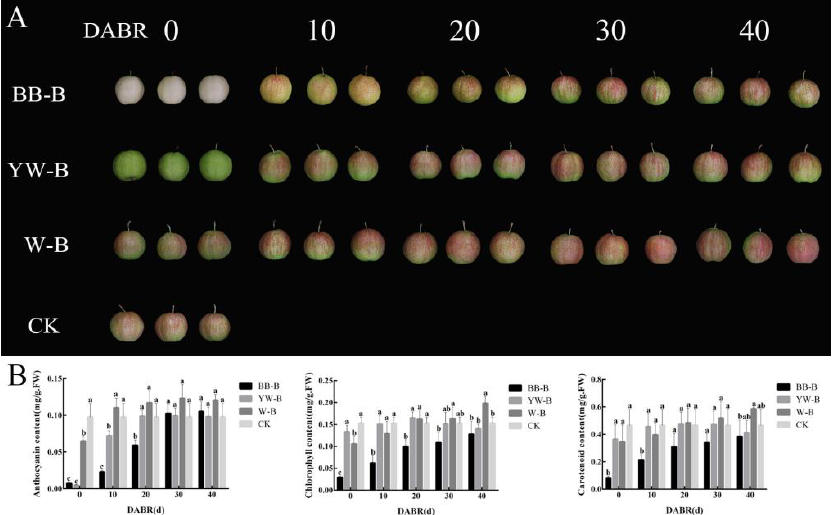
Figure 1. Phenotypes and pigment contents of bagged fruit of ‘Xinqihong’ pears: ( A ) Color phenotype of ‘Xinqihong’ fruit treated by bagging in different types of fruit bag. ( B ) Changes in pigment contents of ‘Xinqihong’ treated with different types of fruit bag. DABR: days after bag removal; BB-B: brown–black-bag-treated fruit; YW-B: yellow–white-bag-treated fruit; W-B: white-bag-treated fruit. Different letters indicate significant